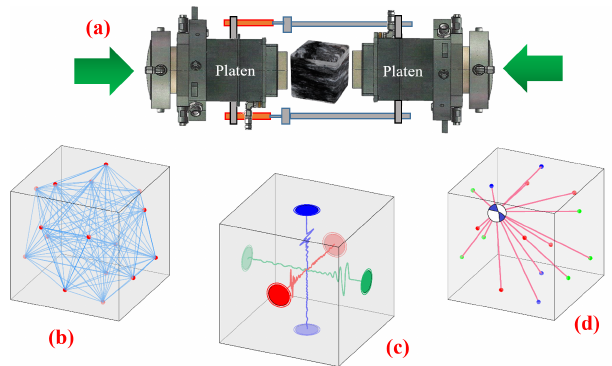
Figure 4. (a) Position of LVDTs on each pair of platens; (b) Active sensor to sensor velocity measurements; (c) P-S1-S2 piezoceramics for velocity surveys; (d) Acoustic Emission Monitoring.